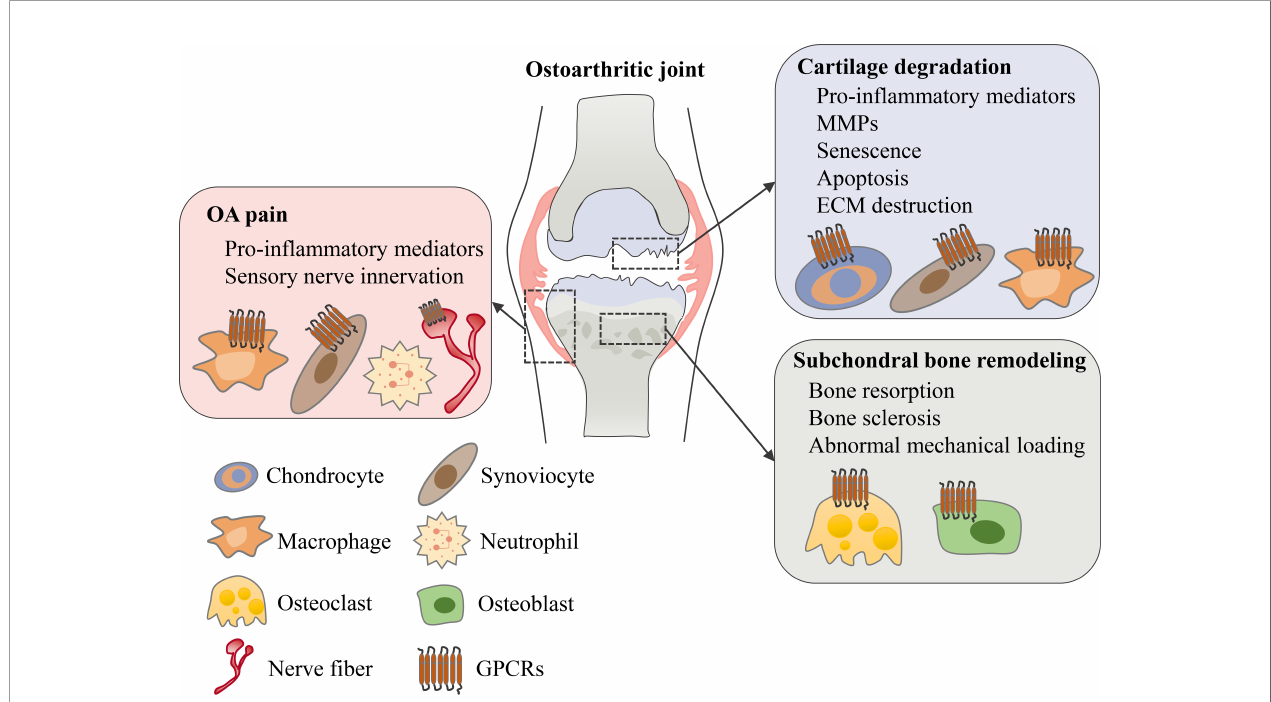
FIGURE 2 | The role of GPCRs in osteoarthritis. In an osteoarthritic joint, GPCRs are expressed in different tissues and cell types. Various types of GPCRs mediate and regulate OA symptoms including cartilage degeneration, subchondral bone remodeling and OA